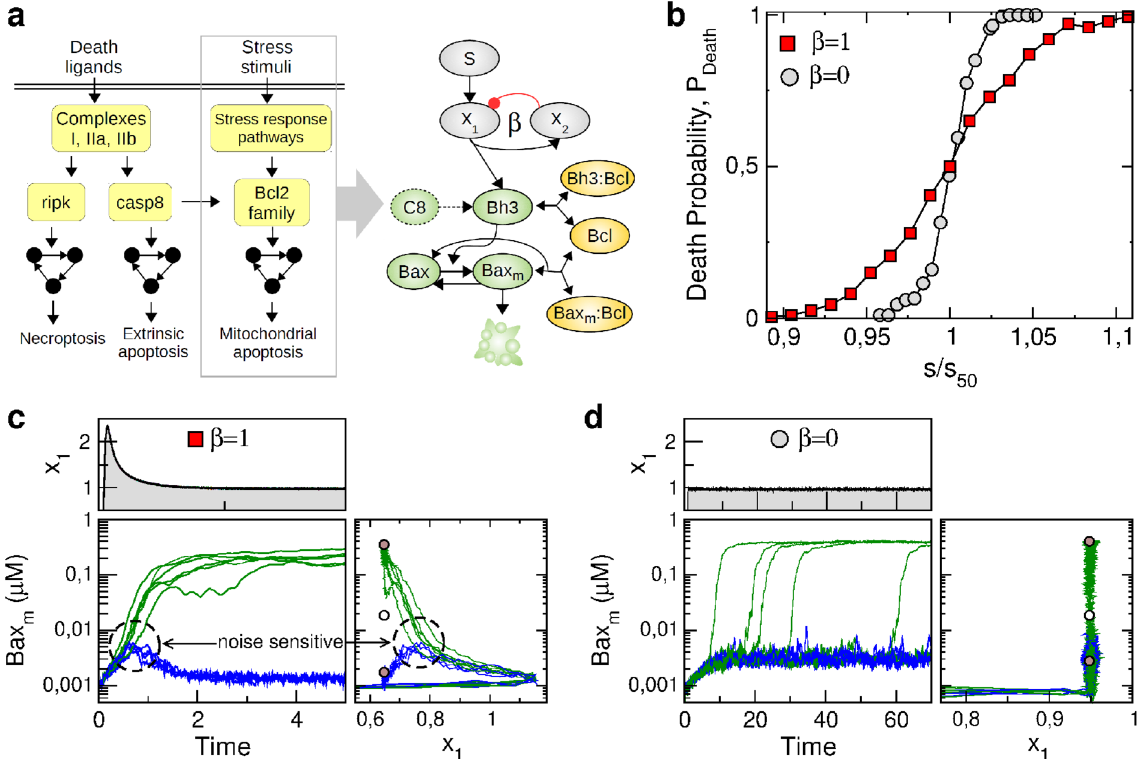
Figure 4. Adaptation-dependent fractional killing in an apoptosis model. ( a ) Some mammalian cell-death pathways associated with fractional killing including the stress-induced mitochondrial pathway of apoptosis (left panel). The detailed model of this study couples the coarse-grained model of stress-induced adaptation module (Eqs. 4a, b) and a published model of the mitochondrial apoptosis initiation module 24 (right panel). ( b ) Death probability as function of the relative stimulus level s / s 50 obtained through numerical simulation of Eq. (1) with σ = 0.002 , where η is about four-fold higher with adaptation ( β = 1 ) compared to without ( β = 0 ). ( c – d ) Temporal trajectories of x 1 and Bax m in the presence or the absence of adaptation ( c : β = 1 ; d : β = 0 ). Adaptation timescale is set to τ = 1.25hr to match with the timescale of the apoptotic switch (time unit is hour). Right panels show a 2D state-space projection of the high-dimensional dynamics with respect to the stable and saddle fixed points (brown and white circles) of the deterministic